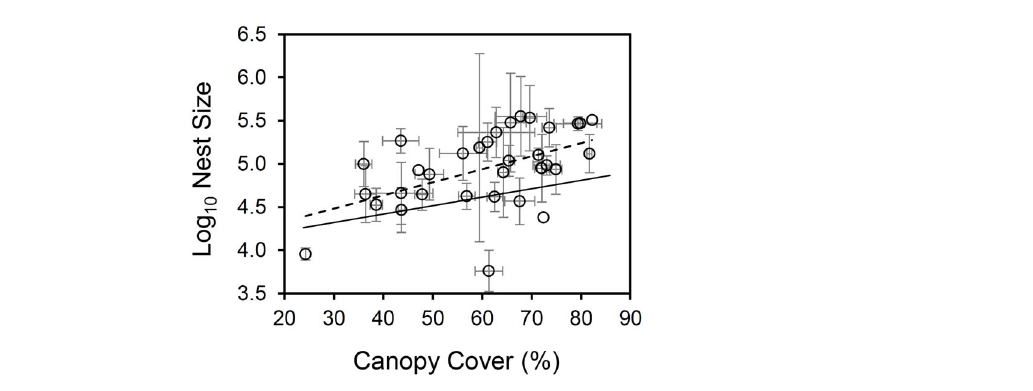
Fig. 1. The relationship between mean nest size and mean canopy cover. Circle dots: the log10 mean nest size and mean canopy cover of 34 colonies; grey error bar: 1 SE, four points without error bars are colonies containing only one nest; dashed line: y 5 0.0149 x + 4.0423, F ratio 5 11.10, P , 0.001, r 2 5 0.26, model fitted by linear regression for the relationship between mean nest size and mean canopy cover; solid line: y 5 0.0097 x + 4.0282, from the fixed effects of the linear mixed-effect model, which includes colony identity as a random effect. Full analyses are showed in results.